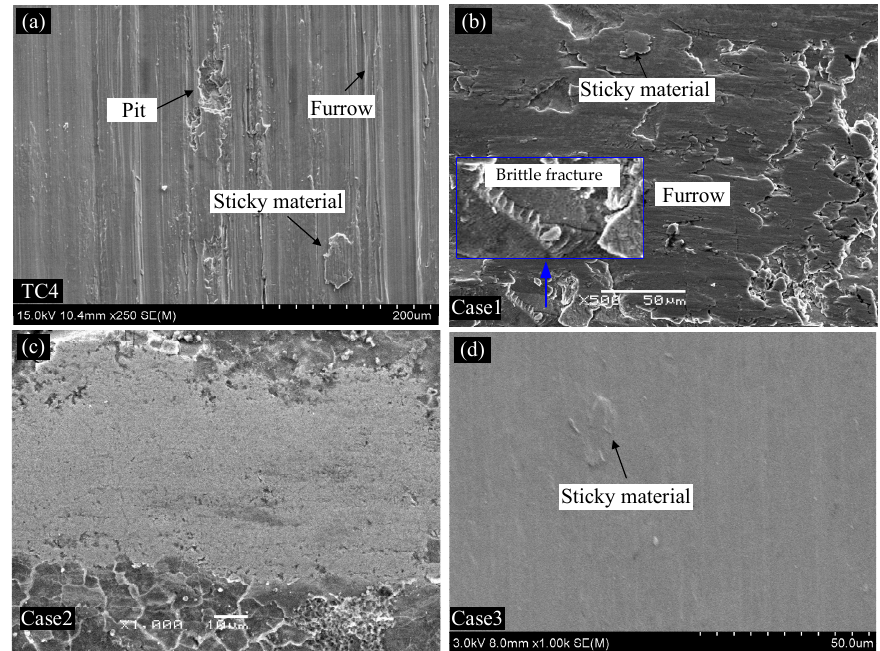
Figure 10. The wear morphology of TC4 and coatings. ( a ) TC4, ( b ) Case 1, ( c ) Case 2, ( d ) Case 3.